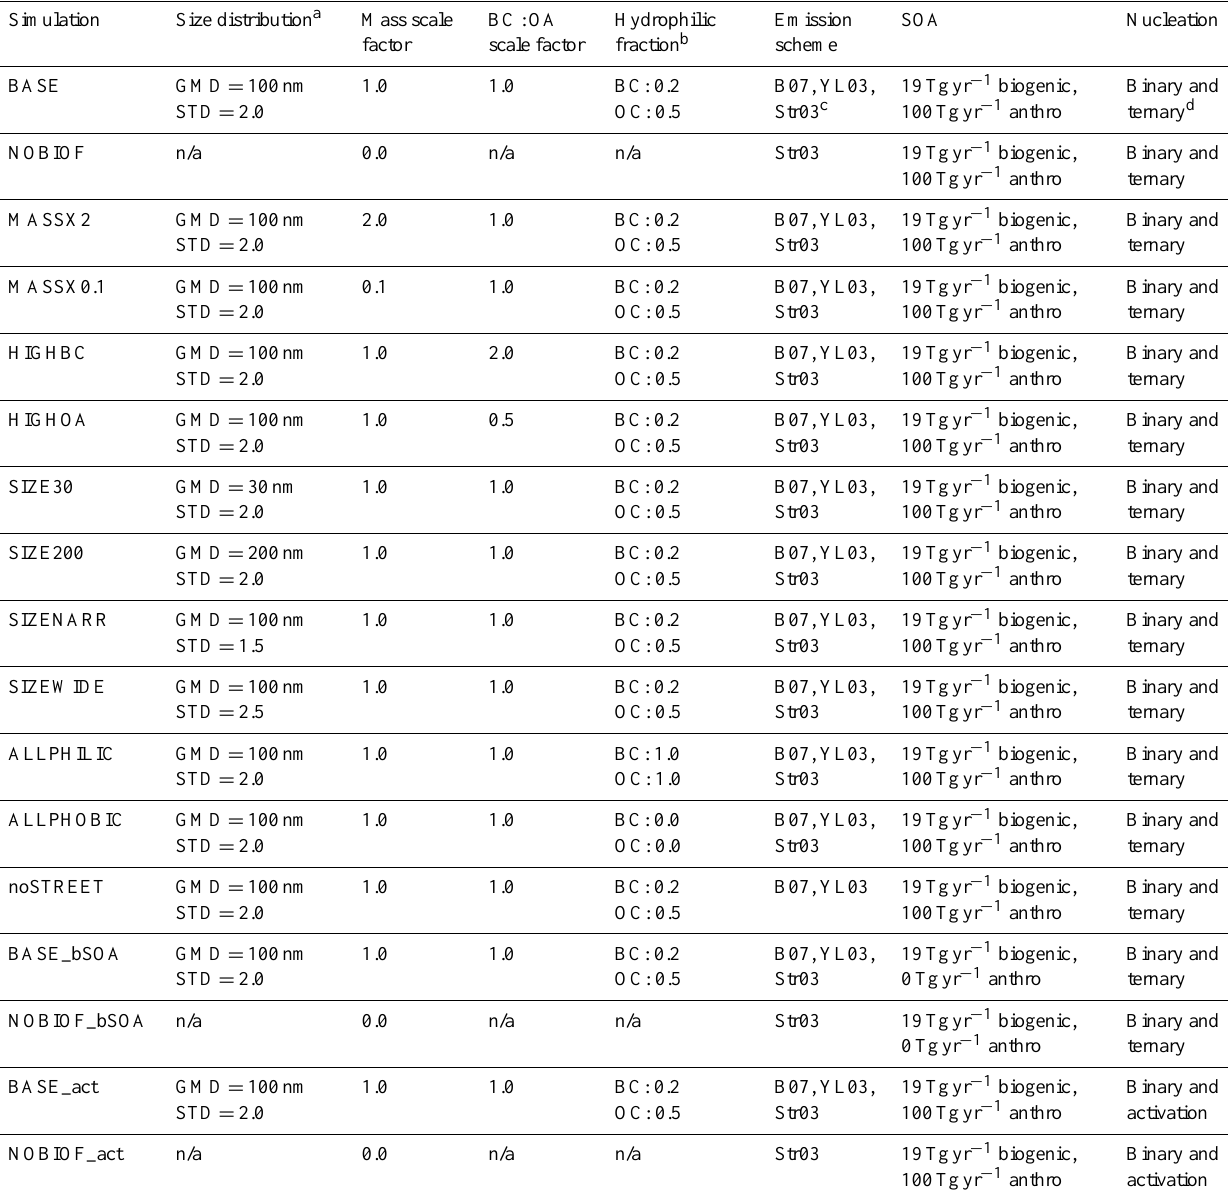
Table 2. Description of